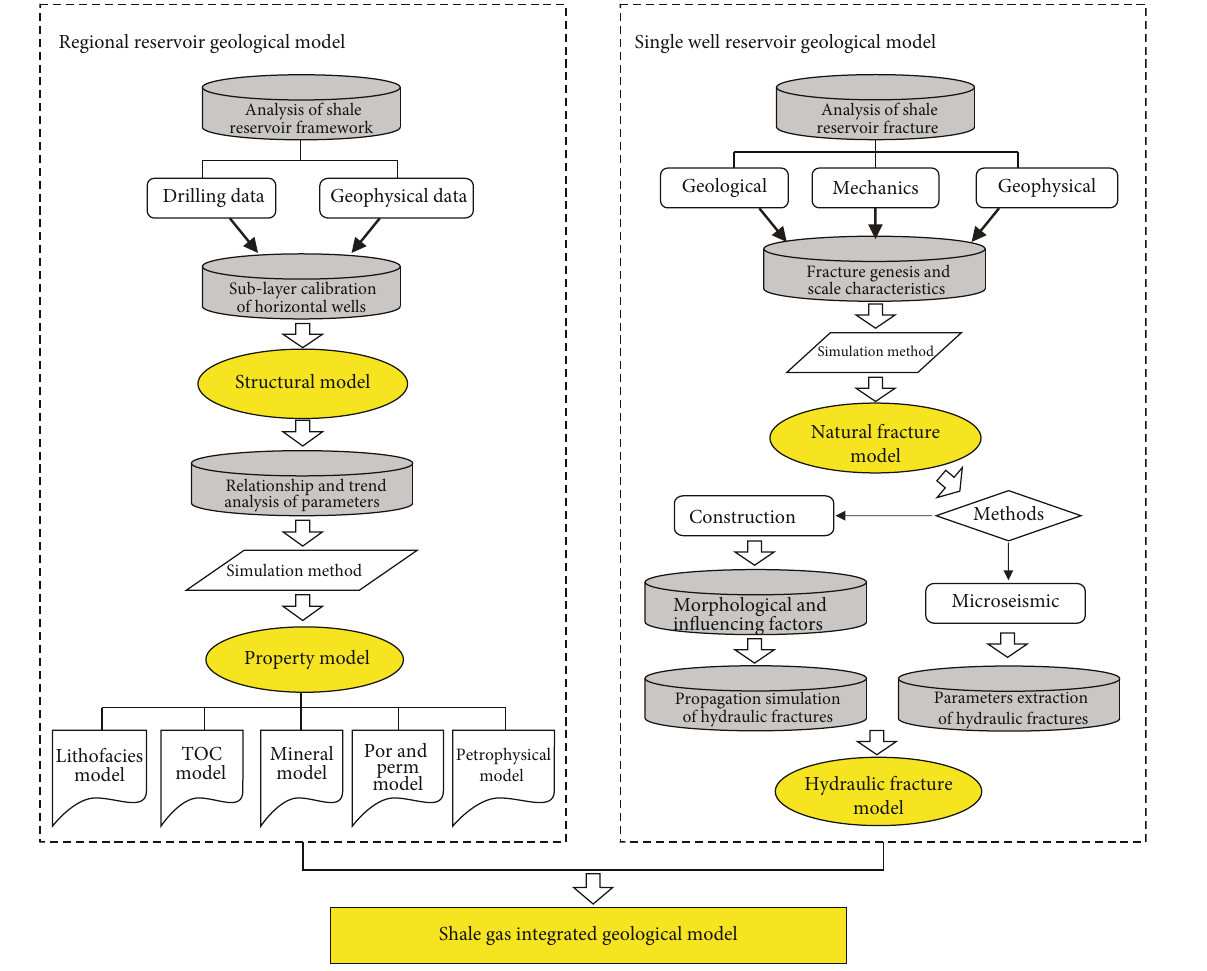
Figure 3: A work fl ow of shale gas geological modeling. An integrated shale gas geological model consists of four models in this work fl ow: structural model, reservoir property model, natural fracture model, and hydraulic fracture model. Di ff erent models have speci fi c corresponding modeling techniques and methods.